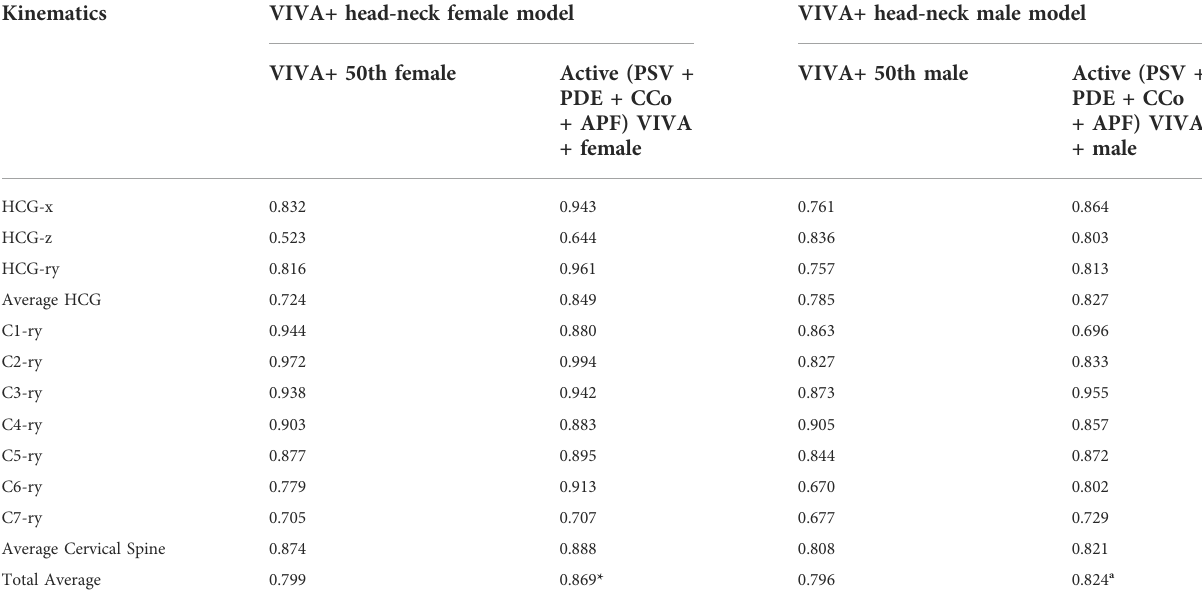
TABLE 4 CORA Score of Head and Cervical Spine Kinematics of Active (PSV + PDE + CCo + APF) VIVA+ Models compared to “ Sato et al. (2014) 5.8 km/h ” .